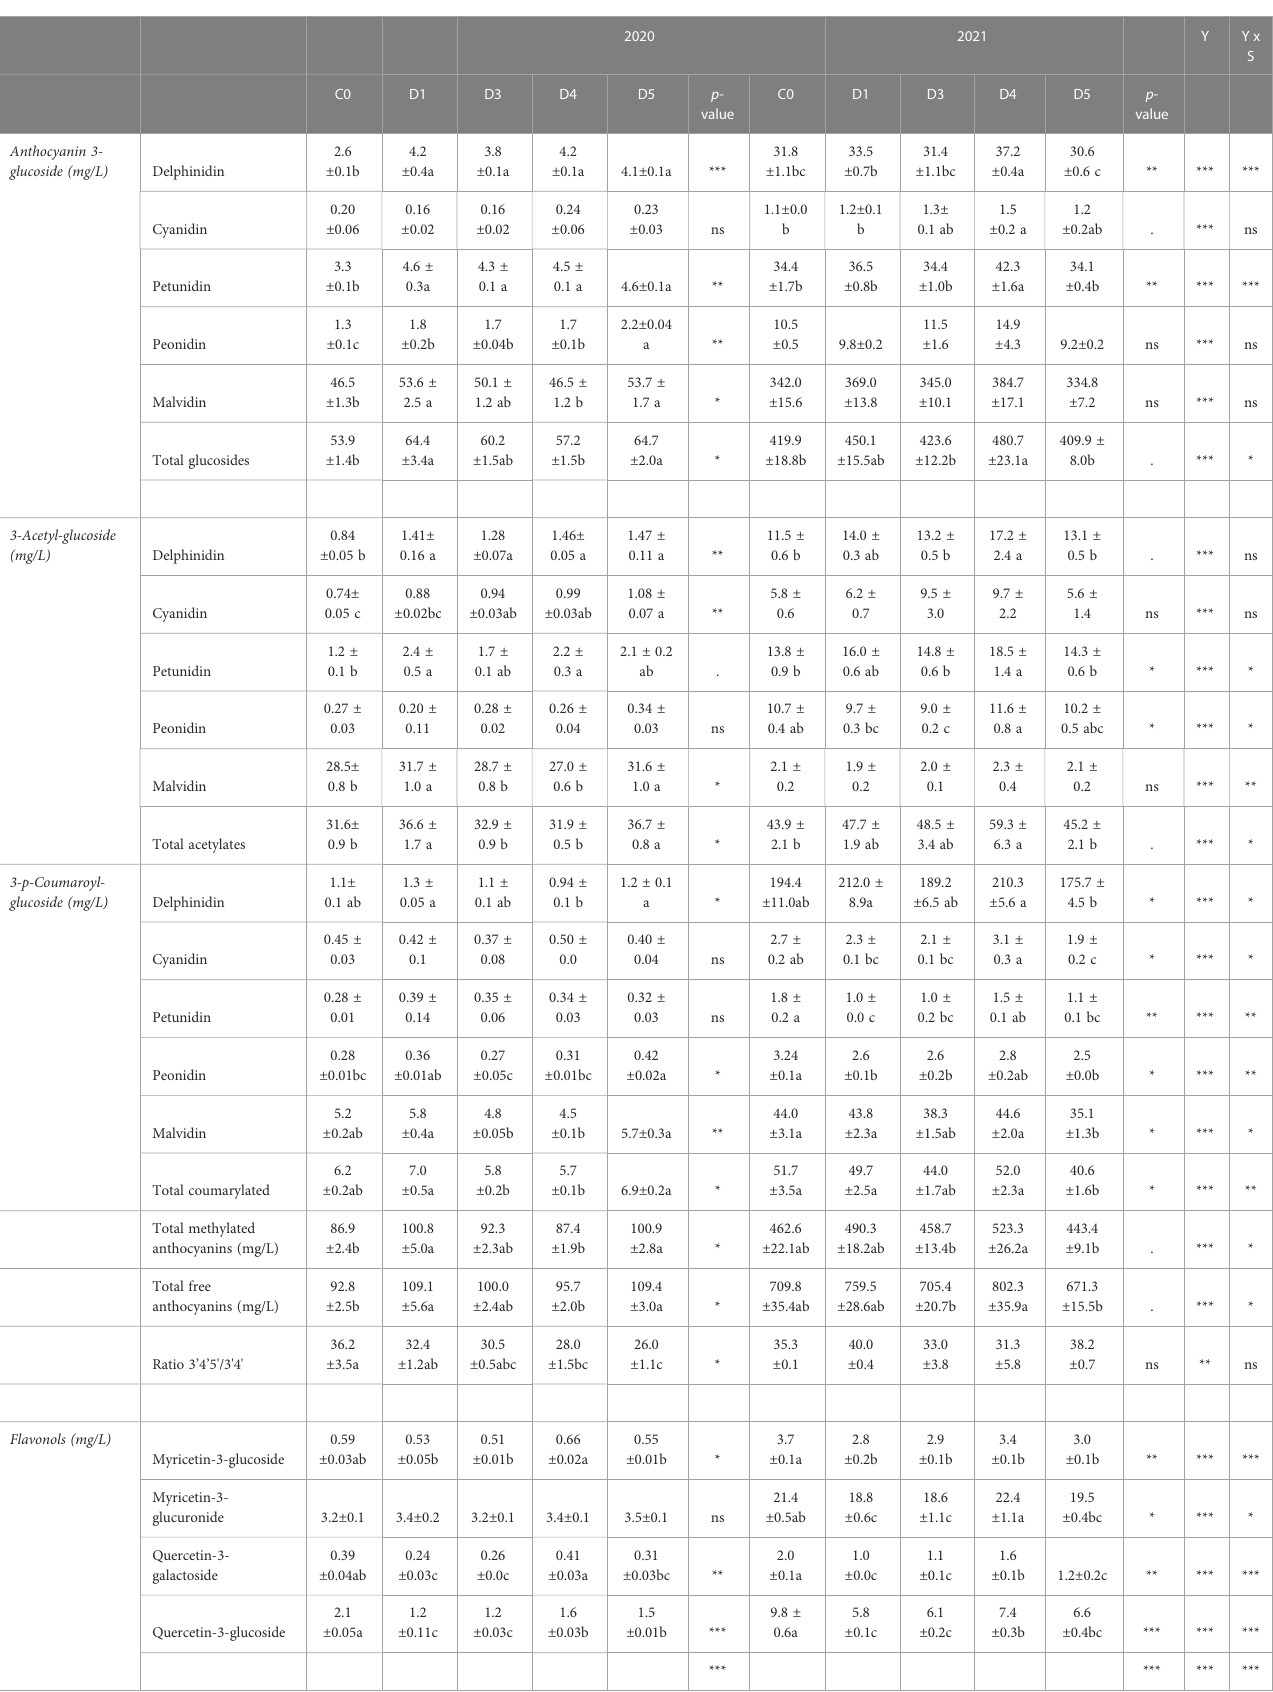
TABLE 2 HPLC separations of fl avonoids in wines from Cabernet Sauvignon grapevines subjected to different photoselective shade fi lm treatments in Oakville, CA, USA in 2020 and 2021 growing seasons a